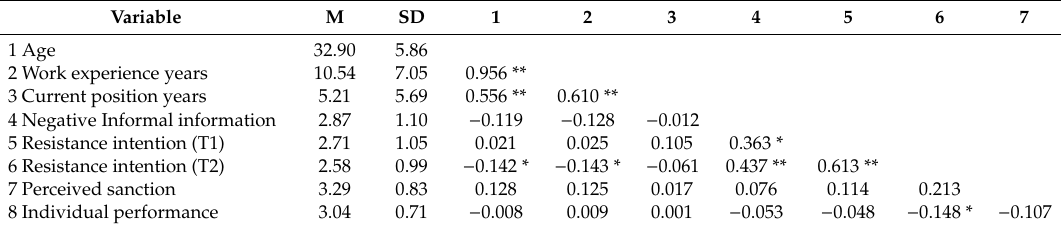
Table 2. Descriptive statistics and correlation matrix for all